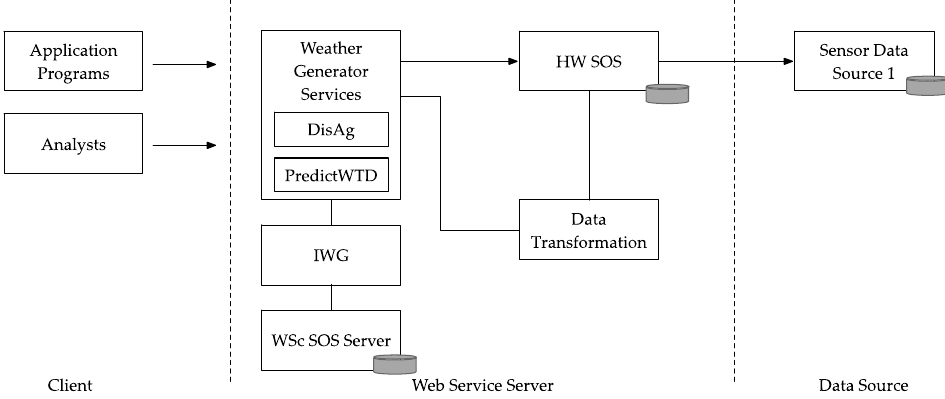
Figure 4. Overview architecture diagram of weather generator web service.